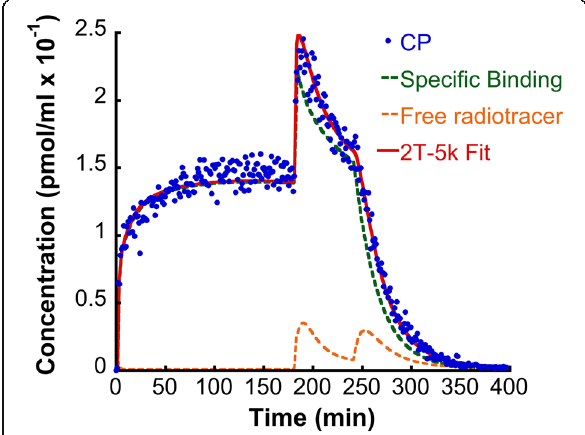
Fig. 1 TACs extracted from the CP of one multi-injection dynamic SPECT scan, along with 2T-5k model fit and the decomposition of the radioactive signal into the specific binding and the free